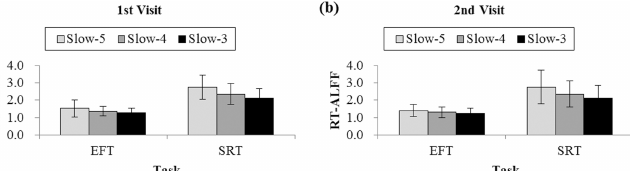
Fig 2. RT-ALFF values for the Slow-5 (0.01–0.027 Hz), Slow-4 (0.027–0.073Hz) and Slow-3 (0.073– 0.167 Hz) of the EFT and SRT. (a) RT-ALFF patterns of the first visit; (b) RT-ALFF patterns of the second visit. For each sub-frequencyband, the SRT generatedhigherRT-ALFF values than the EFT for both visits, and significantTask × Sub-frequency Band interactionswere found for both visits. RT-ALFF differences betweentasks were found to be the most significantfor